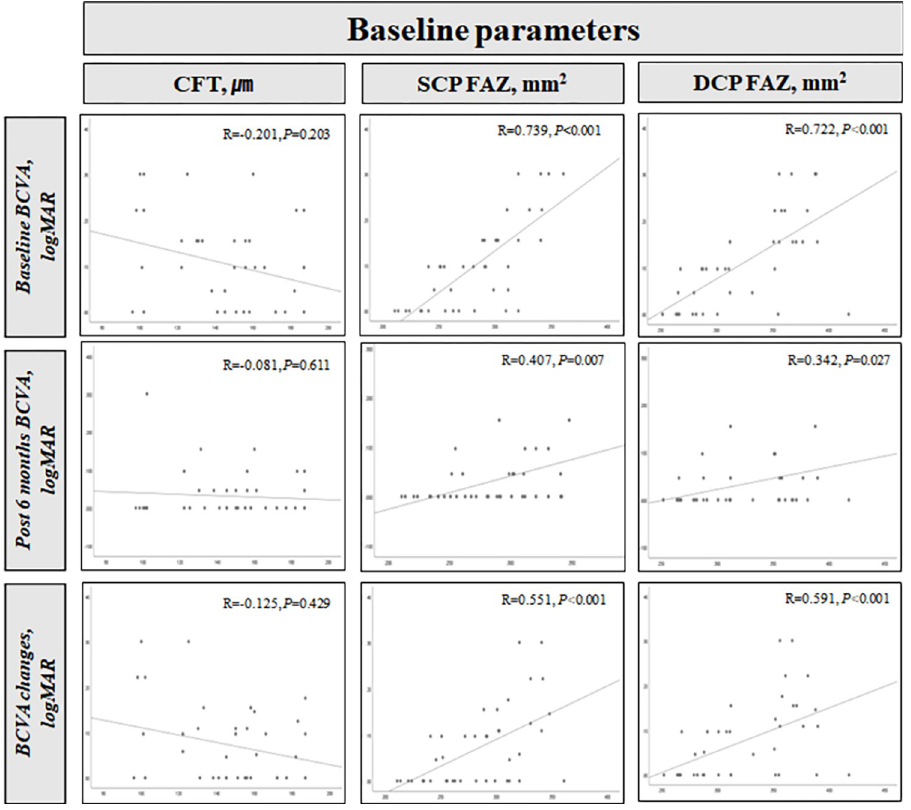
Fig 4. Graphs showing the correlation between variables before PDT (CFT, SCP FAZ, and DCP FAZ) and baseline BCVA, 6 months post-PDT BCVA, and BCVA changes over 6 months. BCVA-related variables show a significant correlation with both SCP FAZ and DCP FAZ (all p < 0.01). CFT, central foveal thickness; SCP, superficial capillary plexus; DCP, deep capillary plexus; FAZ, foveal avascular zone; R, Spearman’s rho coefficient; BCVA, best corrected visual acuity; logMAR, logarithm of the minimum angle of resolution; PDT, photodynamic therapy.